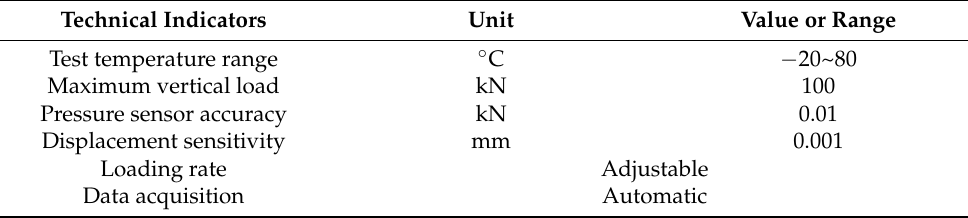
Table 1. The main technical parameters of